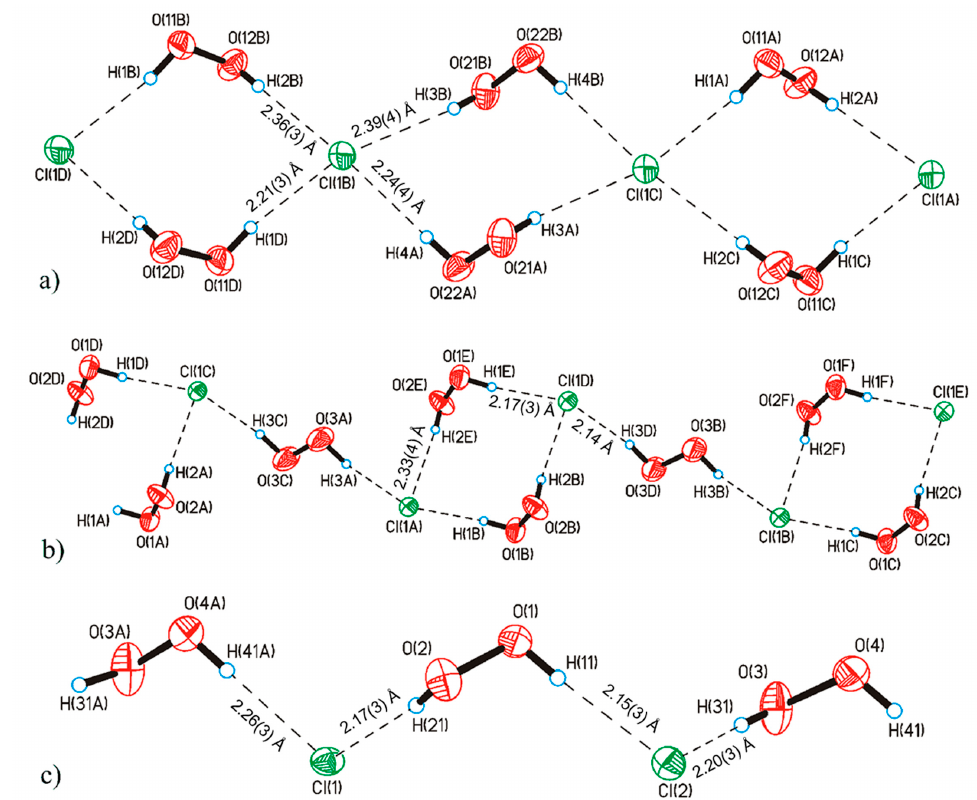
Figure 4. Structure of hydrogen peroxide clusters formed in crystalline Ph 4 AsCl· n H 2 O 2 : ( a ) [( Н 2 О 2 ) 2 (Cl – ) 1 ] inf chains at n = 2; ( b ) [( Н 2 О 2 ) 3 (Cl – ) 2 ] inf chains at n = 1.5; ( c ) [( Н 2 О 2 ) 1 (Cl − ) 1 ] inf chains at n = 1. O-H···Cl − bonds are denoted by dotted lines. Distances H···Cl − are presented. Reproduced from the work in [45] with permission from The Royal Society of Chemistry.